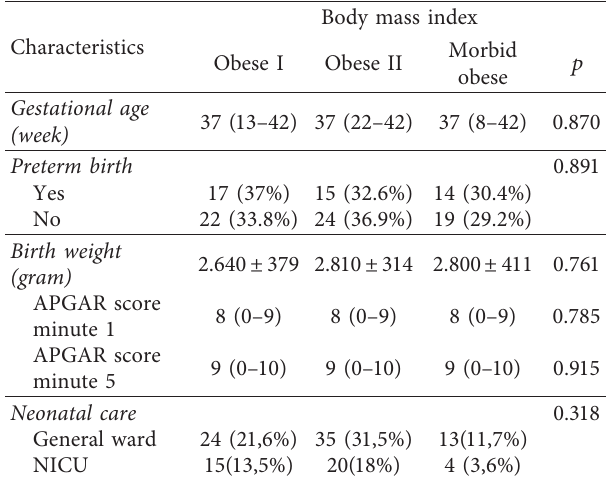
Table 3: Maternal outcomes. Table 4: Perinatal